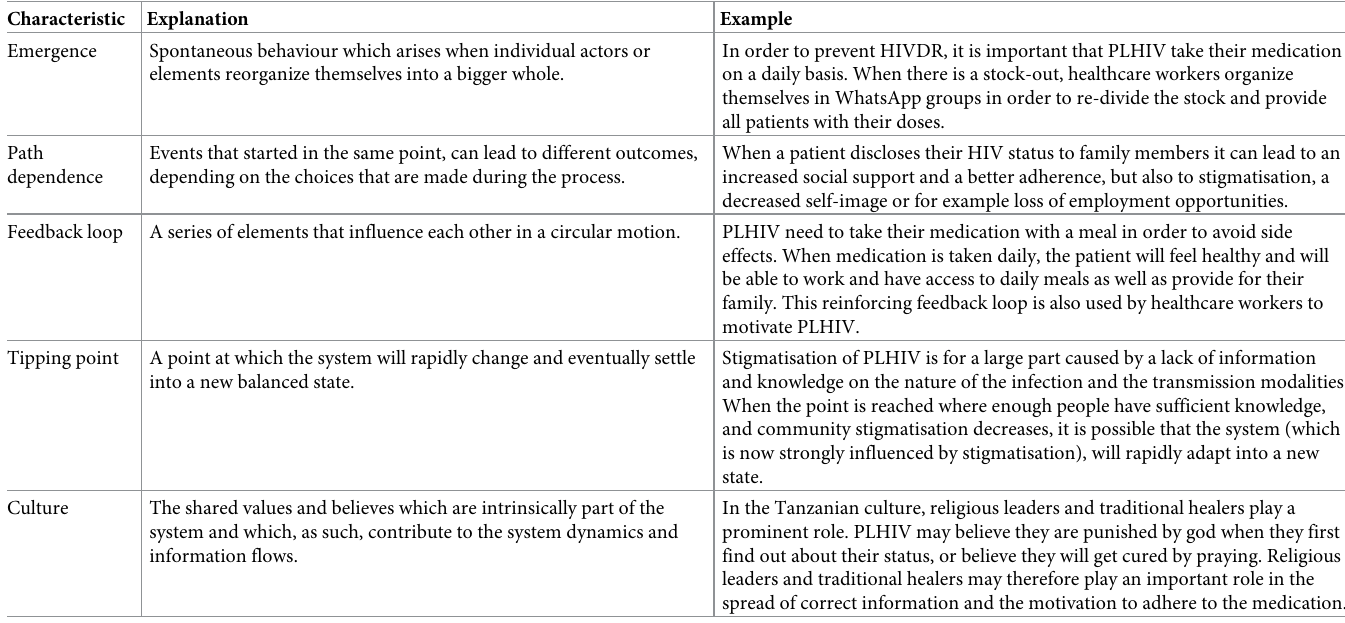
Table 3. Dynamic characteristics of